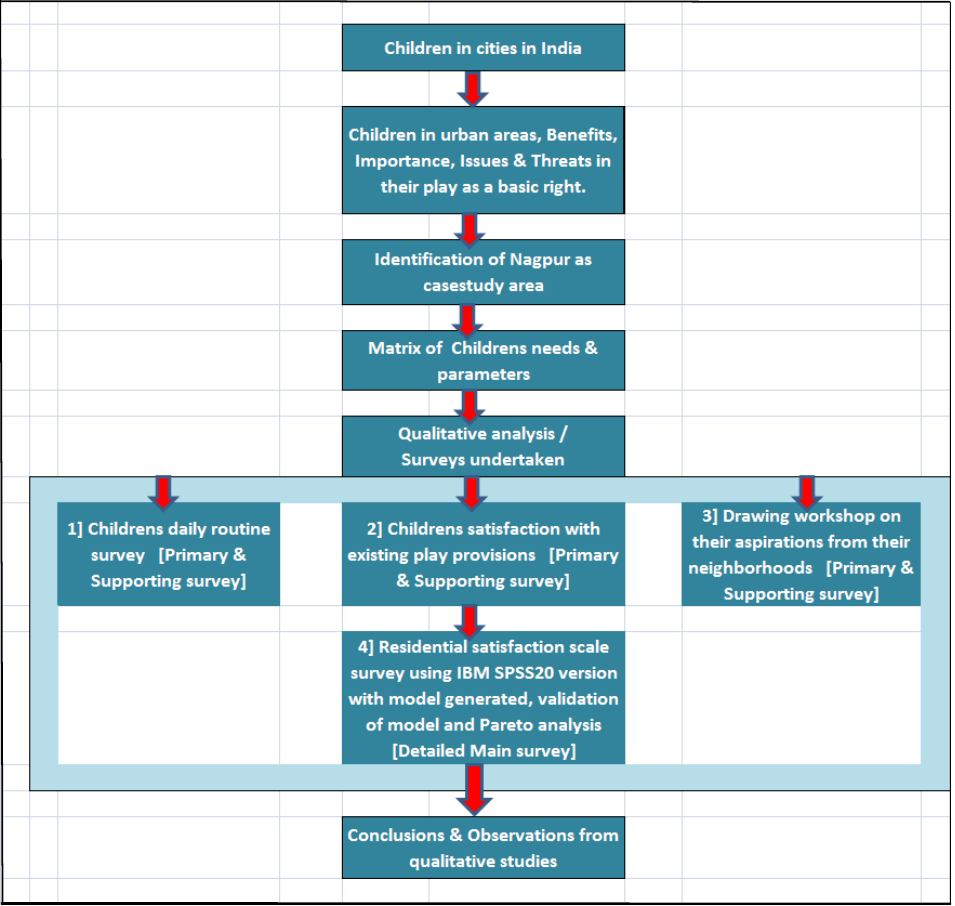
Figure 2. Methodology of study.